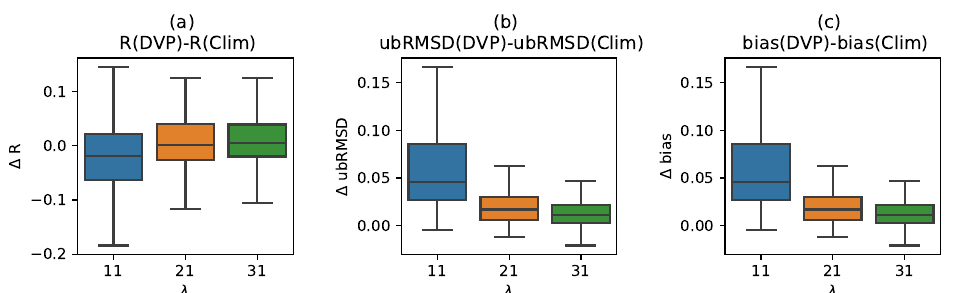
Figure 11. Box plot of the difference in ( a ) Pearson correlation coefficient (R), ( b ) unbiased RMSD and ( c ) bias between in situ soil moisture and soil moisture retrieved using vegetation parameters derived using dynamic vegetation parameters ( λ on x-axis) and those derived from climatological values for all stations. The box extends from the lower to upper quartile values of the data, with a line at the median. The lower whisker is at the lowest datum above Q1 − 1.5 ∗ (Q3 − Q1) and the upper whisker at the highest datum below Q3 + 1.5 ∗ (Q3 − Q1), where Q1 and Q3 are the first and third quartiles. Outliers are omitted for